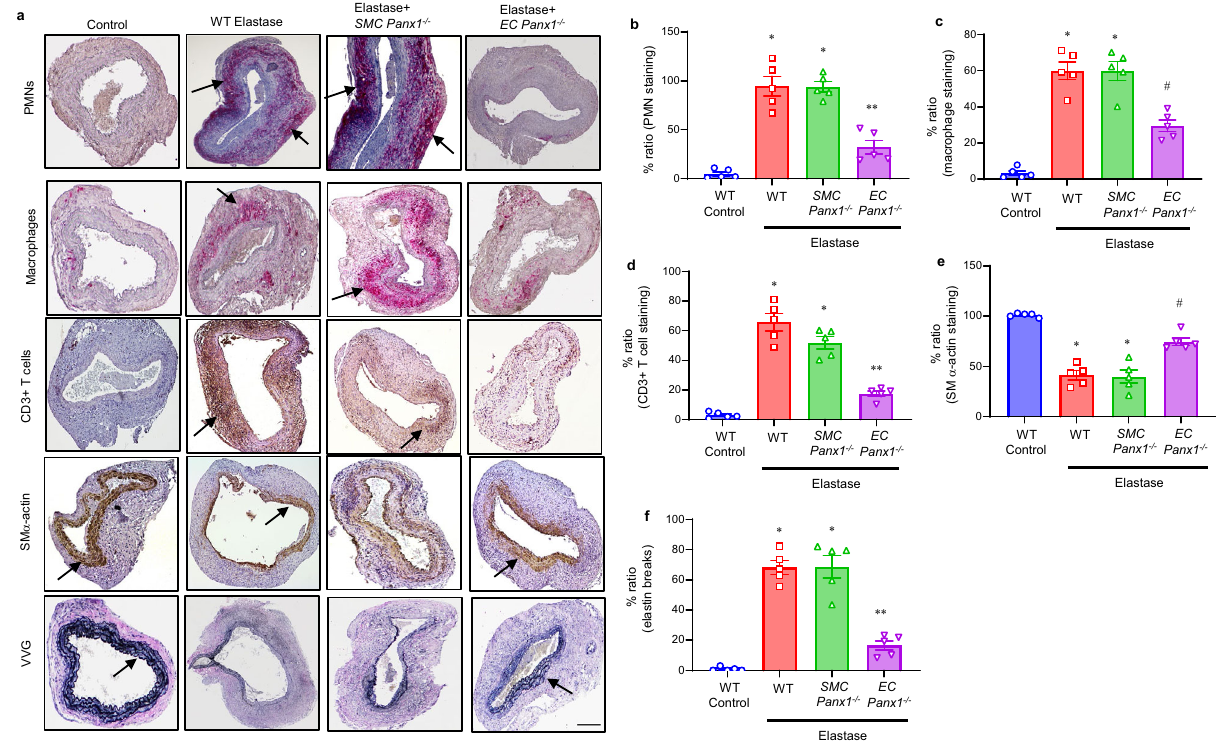
Fig. 2 Panx1 deletion on endothelial cells mitigates leukocyte traf fi cking in AAA. a Comparative histology and immunohistochemistry performed on day 14 indicates a marked decrease in CD3 + T cell, neutrophil (PMN), and macrophage (Mac-2) immunostaining, increase in smooth-muscle-cell α -actin (SM α -actin) expression, and decrease in elastic- fi ber disruption in aortic tissue (Verhoeff – Van Gieson, VVG staining for elastin) of elastase-treated EC- Panx1 − / − mice compared with elastase-treated WT and SMC-Panx1 − / − mice. n = 5/group. Arrows indicate areas of immunostaining. Scale bar is 200 μ m. b – f Quanti fi cation of immunohistochemical staining demonstrating a signi fi cant decrease in neutrophils (PMNs), macrophages, CD3 + T cells, and elastin degradation (VVG) staining, as well as increase in smooth muscle α -actin expression in elastase-treated EC Panx1 − / − aortic tissue compared with elastase- treated WT and SMC-Panx1 − / − mice. No signi fi cant differences were observed between elastase-treated WT and SMC-Panx1 − / − mice. * P < 0.0001 vs. WT control; ** P < 0.0001 vs. WT elastase and SMC-Panx1 − / − ; # P = 0.0003 vs. WT elastase and SMC-Panx1 − / − . Data is represented as mean values ± SEM and comparative statistical analyses were done by one-way